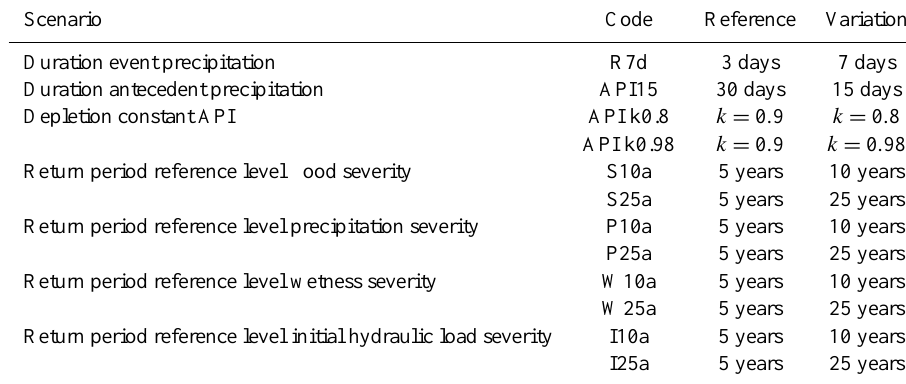
Figure 12. Locally weighted scatterplot smooth (LOWESS) model for the relationship between precipitation and wetness indices as predic- tors for the flood severity index (grey colour code) of past large-scale flood events in Germany. Top left: Reference (5-year return period as reference level for severity indices, R3d, API 30 days, k = 0 . 9); top right: 10-year return period as reference level for severity indices; bottom left: R7d; bottom right: API k0.98. Note that all severity indices have been normalized to the respective maximum values and that the upper right corners do not contain observed data. Table 3. Variation scenarios examined within sensitivity